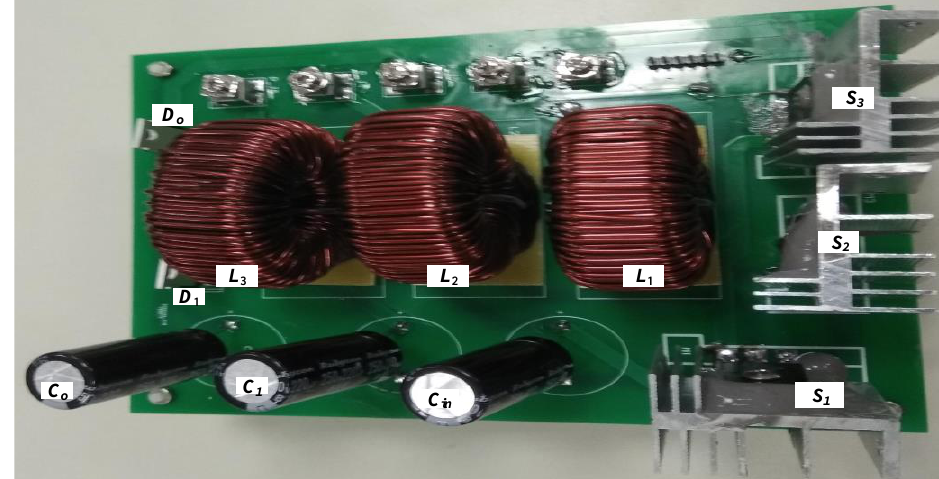
Figure 11. A photo of the hardware. The three switches are triggered simultaneously to avoid any short circuits; hence, no deadtime is added to the controller. Switches S 2 and S 3 face similar voltage stress, while S 1 encounters a different voltage stress (see Figure 12). Figure 12 is a case of study in which the duty cycle is set to 0.4, the input voltage is 35 V, and the measured output across the converter voltage is around 130 V.